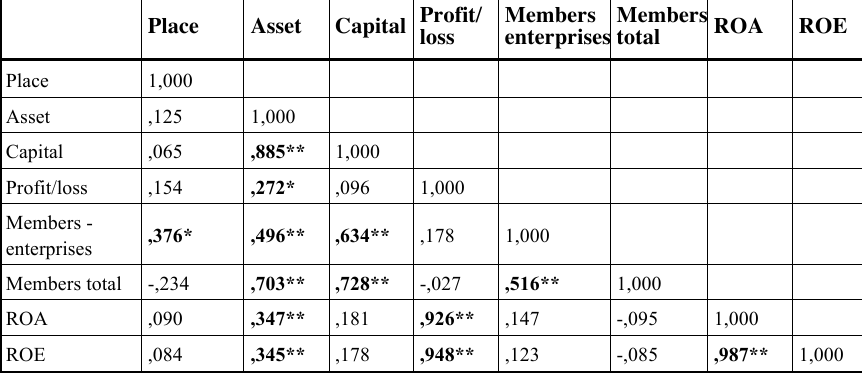
Table 5. Correlations of financial and statistical CUs data (calculated using data from LB,